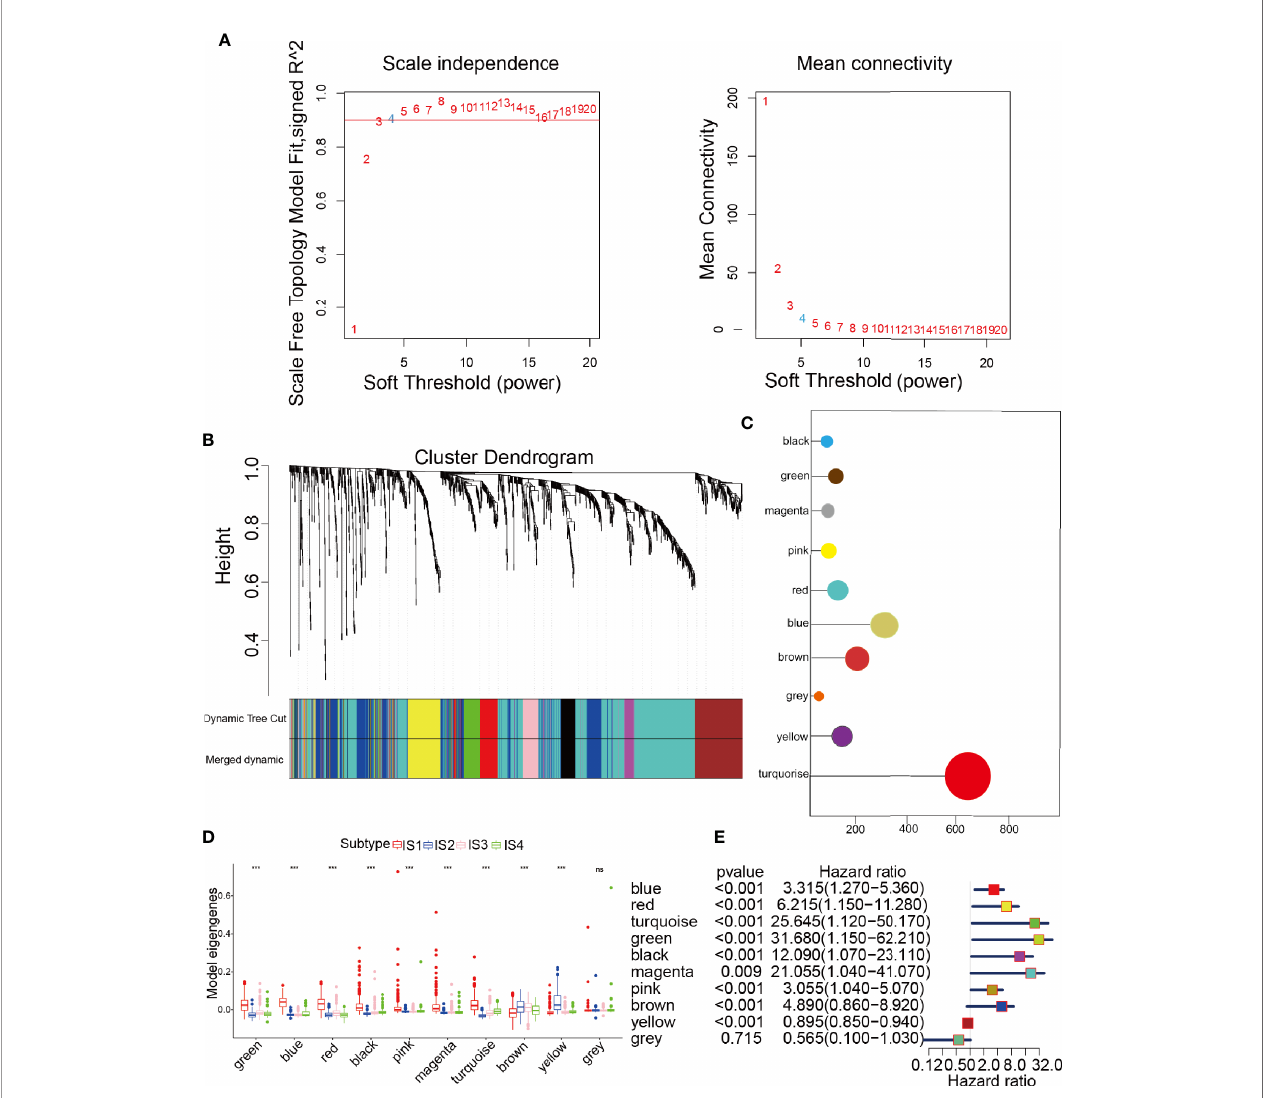
FIGURE 8 | Characterization of the immune gene coexpression module of glioma. (A) Determination of the scale-free fi t index ( b ) for every soft threshold power. (B) Treemap of all immune-related genes clustered based on the TOM matrix. (C) Number of genes in every module. (D) Differential distribution of module eigengenes in glioma immune types. (E) Univariate Cox regression analysis of nine signi fi cant models. ***p < 0.001 and ns, non-signi fi